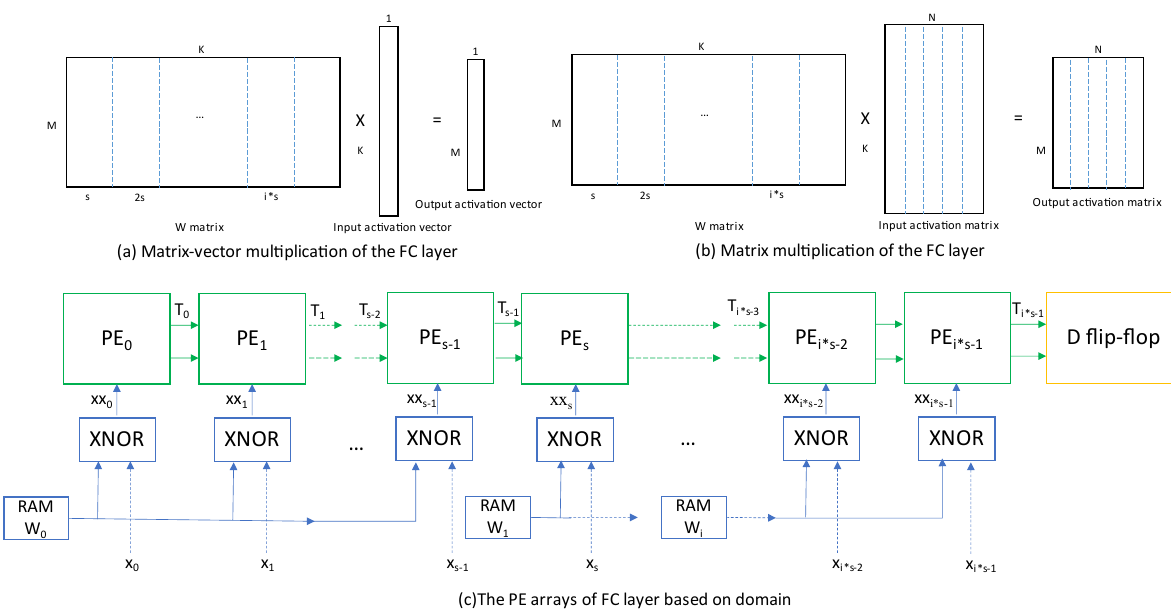
Figure 10. The middle FC layer structure based on time domain.